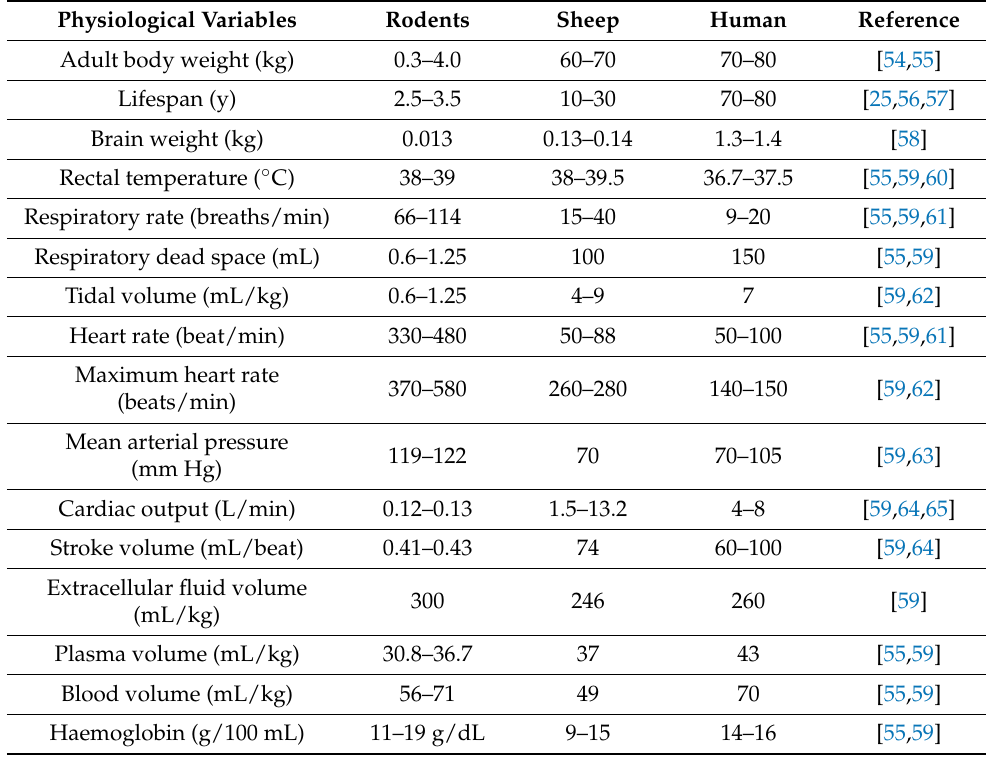
Table 2. Comparison of common physiological variables of adult (male) rodents, sheep, and humans. Physiological